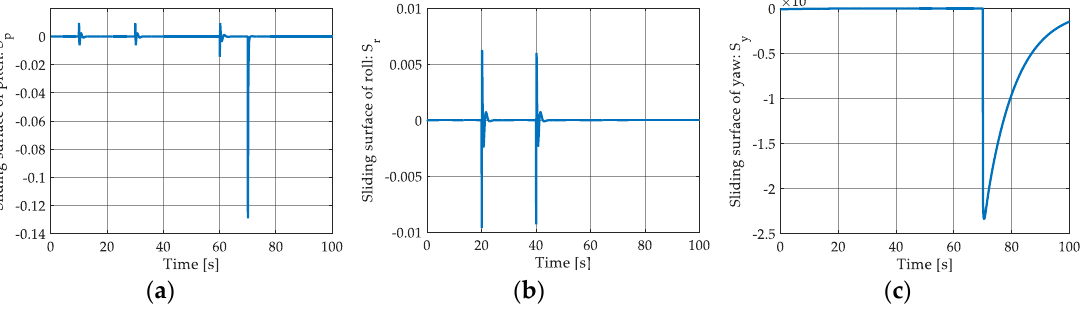
Figure 13. Sliding surface: ( a ) Pitch angle; ( b ) roll angle; ( c ) yaw angle.